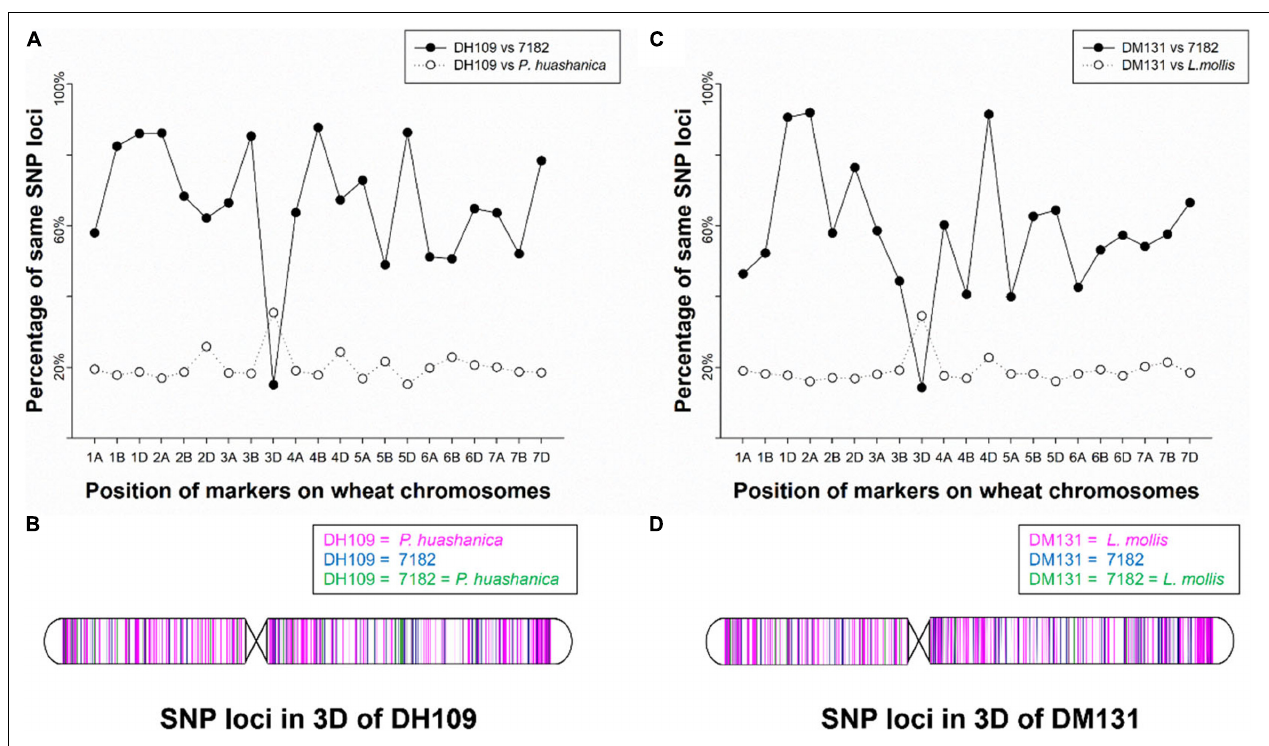
FIGURE 7 | Chromosomal compositions of DH109 and DM131 using wheat 55K SNP array. (A) An obvious crossing point in the position of 3D chromosome according to percentages of the same SNP loci between DH109 and its parents. (B) Physical positions of the same SNP loci in the 3D chromosome according to genotype of DH109 with its parents. (C) An obvious crossing point in the position of 3D chromosome according to percentages of the same SNP loci between DM131 and its parents. (D) Physical positions of the same SNP loci in the 3D chromosome according to genotype of DM131 with its